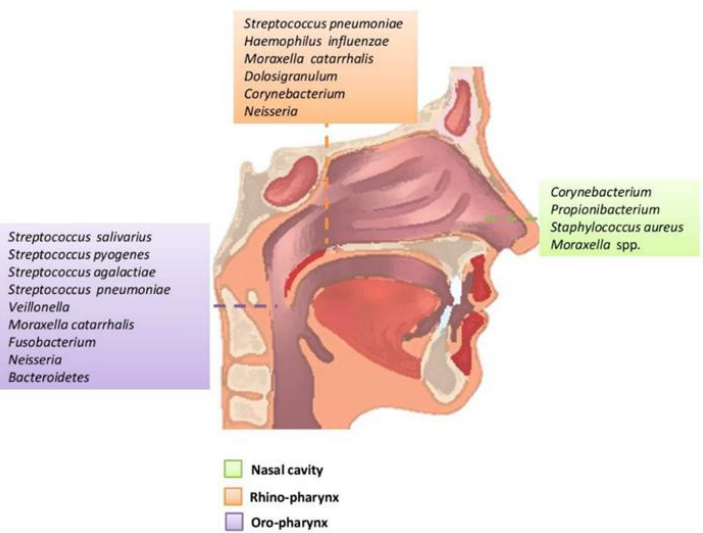
Figure 2. Principal genera of bacteria present in upper respiratory tract of adults. Reproduced with permission from [30].